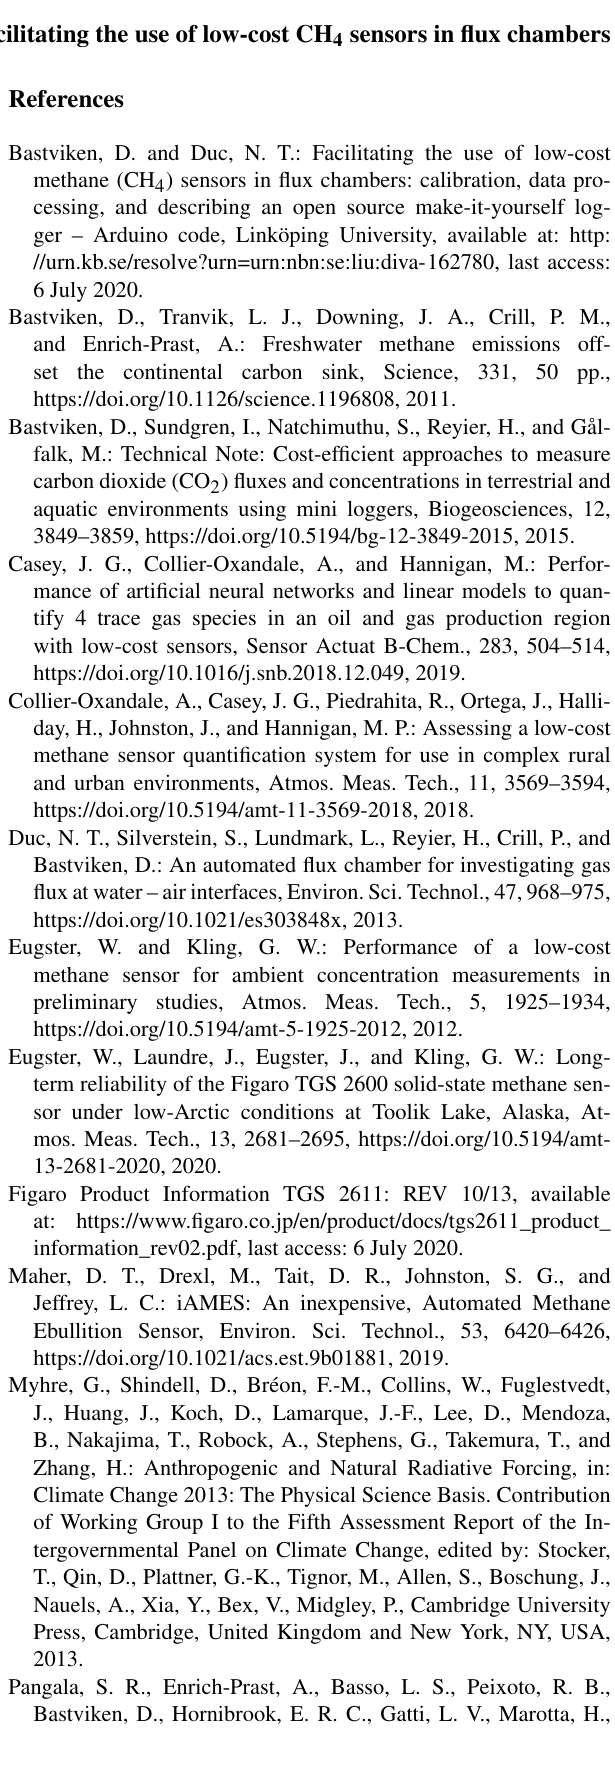
Figaro Product Information TGS 2611: REV 10/13,